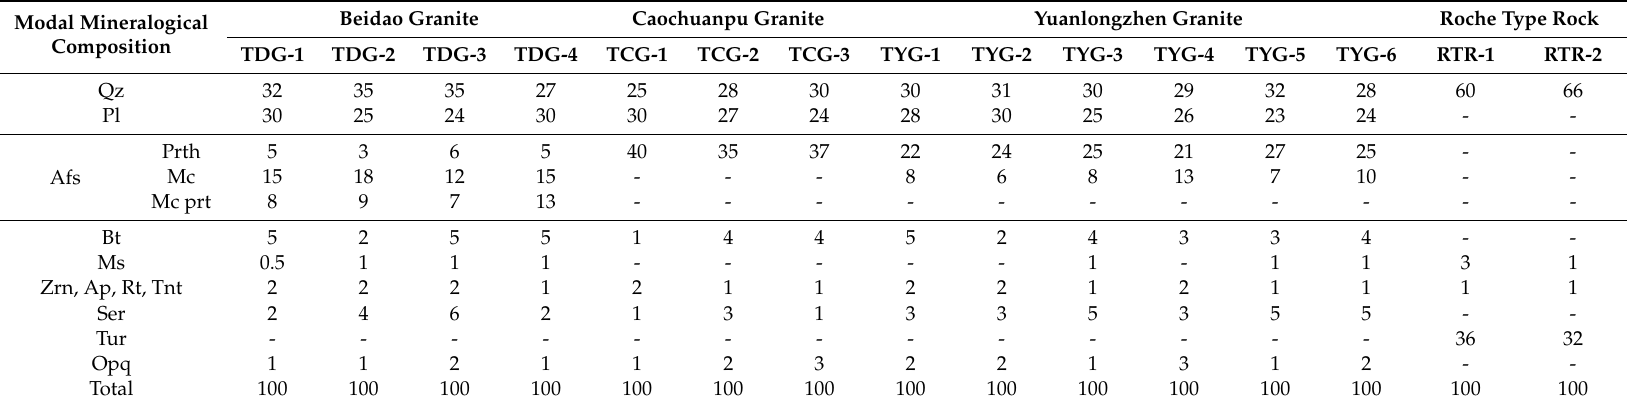
Table 1. The modal mineralogical composition of granites and Roche type rock in the Western Qinling Orogenic Belt (WQOB). Modal Mineralogical